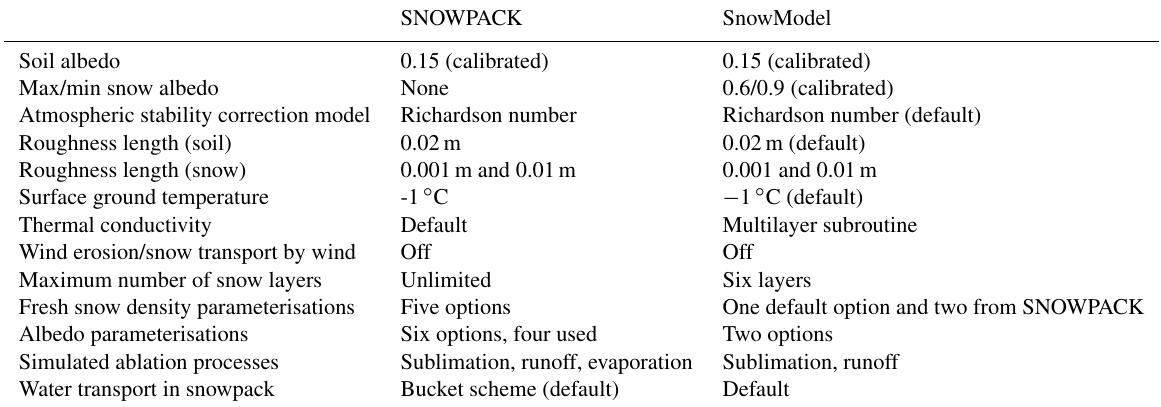
Table 2. SNOWPACK and SnowModel parameter characteristics. The possible snow albedo parameterisations and fresh snow density models are described in Sect. S1 in the